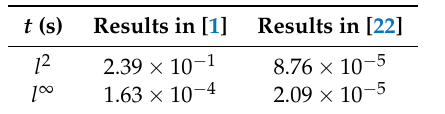
Table 3. l 2 and l ∞ norms of the errors of the papers [1,22].